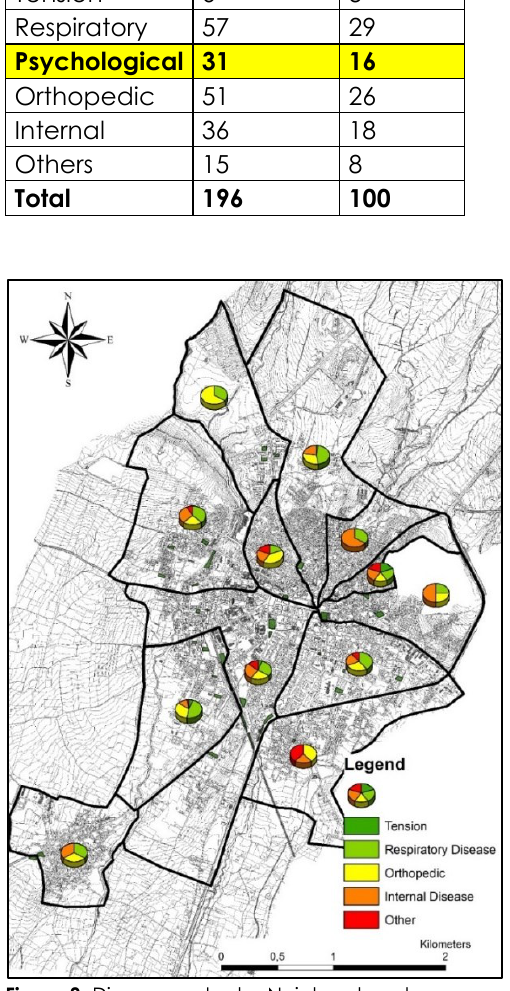
Figure 8. Disease reates by